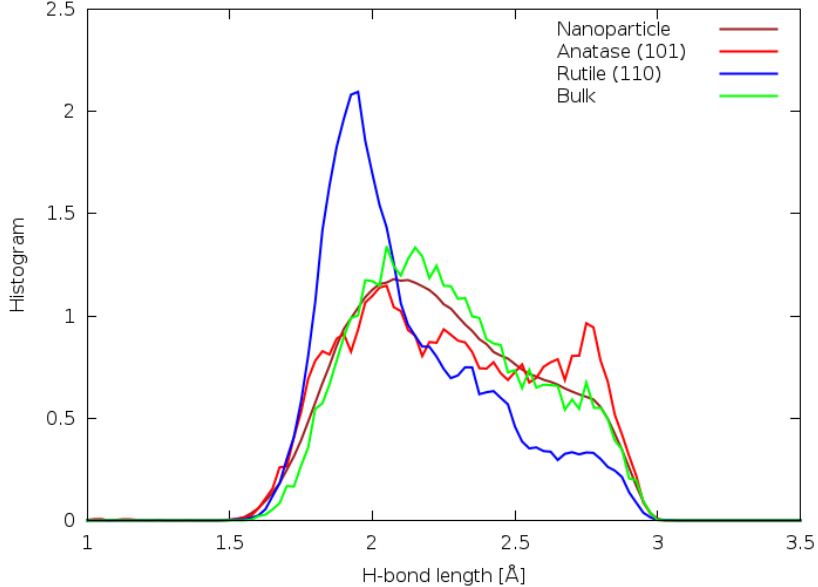
Figure 7. Average hydrogen bond length for various systems simulated with DFTB. The y-axis is the frequency of that bond length occurring, normalised to the same scale for all systems.